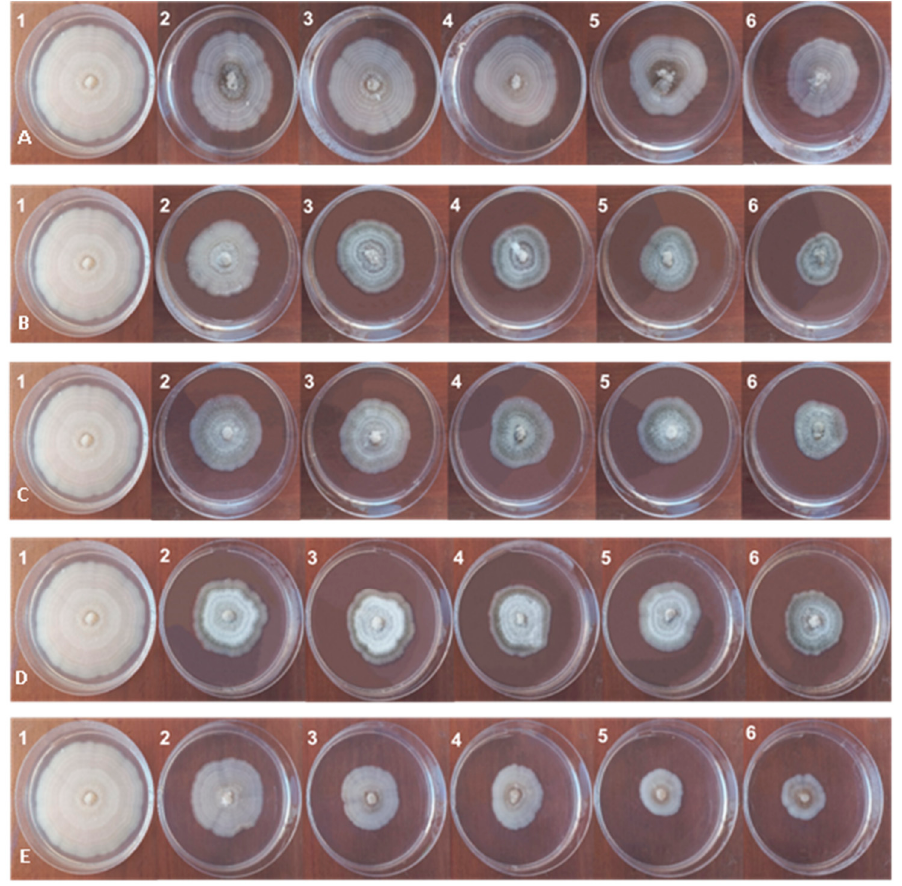
Figure 1. Colletotrichum musae colonies submitted to Dipteryx punctata extracts and to the coumarin standard, at concentrations of 10%, 20%, 30%, 40% and 50%. ( A ) Extract of leaves from area 4: control (1); concentrations (2, 3, 4, 5 and 6). ( B ) Extract of branches from area 2: control (1); concentrations (2, 3, 4, 5 and 6). ( C ) Extract from residues from area 1: control (1); concentrations (2, 3, 4, 5 and 6). ( D ) Seed extract from area 4: control (1); concentrations (2, 3, 4, 5 and 6). ( E ) Coumarine pattern: control (1); concentrations (2, 3, 4, 5 and 6). Source: the authors. The percentage of inhibition of C. musae growth in the other treatments ranged from 46.6% to 63.3% at the highest concentration and from 24.8% to 44.6% at the lowest tested concentrations of the different products. Only at the concentration of 10% for the extract of leaves (area 2) and extract of residues (areas 3, 4 and 5) was the PIG not higher than 30% (Table